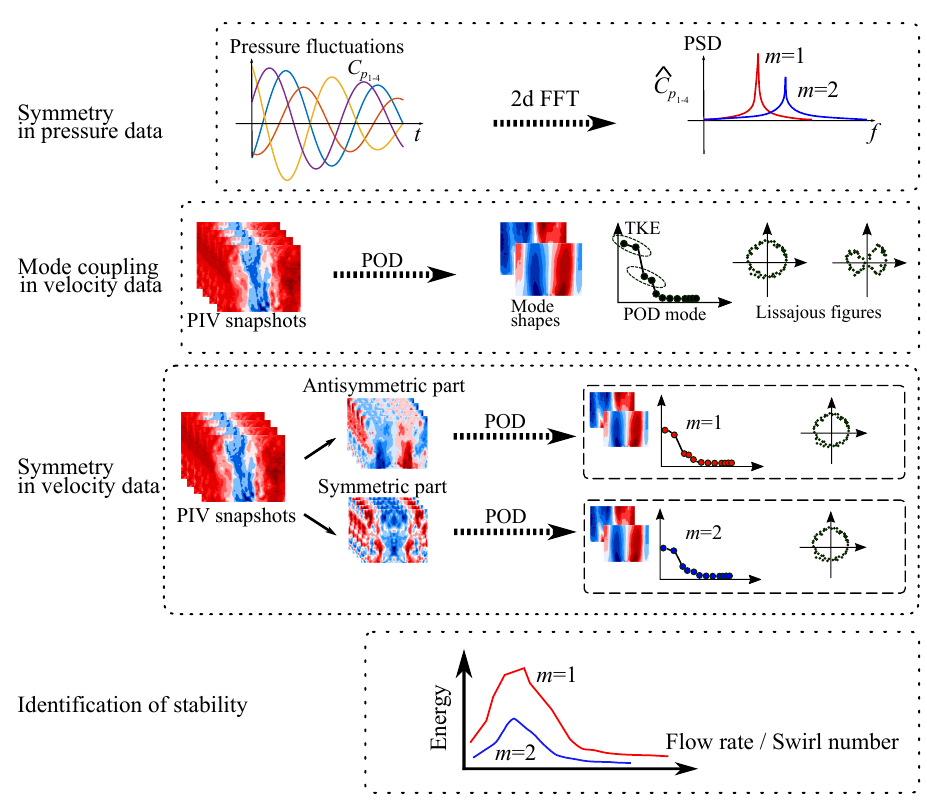
Figure 2. Decomposition methods used in this